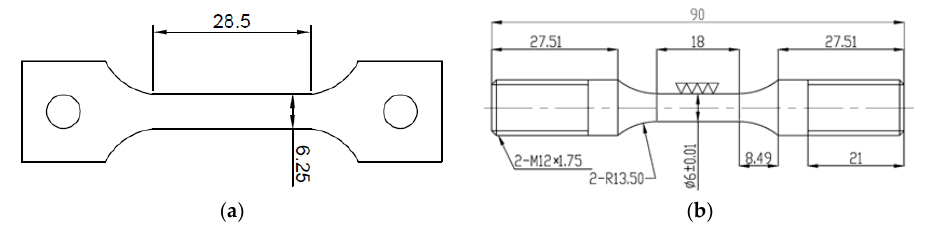
Figure 2. Specimen’s geometry of the ( a ) Tensile and ( b ) LCF test. LCF, Low Cycle Fatigue.